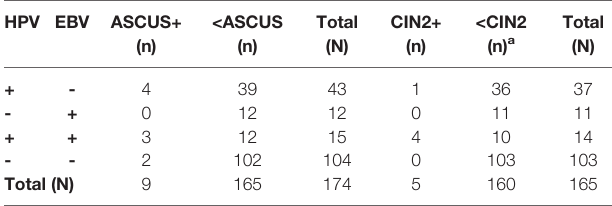
TABLE 2 | Detailed information on HPV and EBV distribution among 165 HIV- positive women.